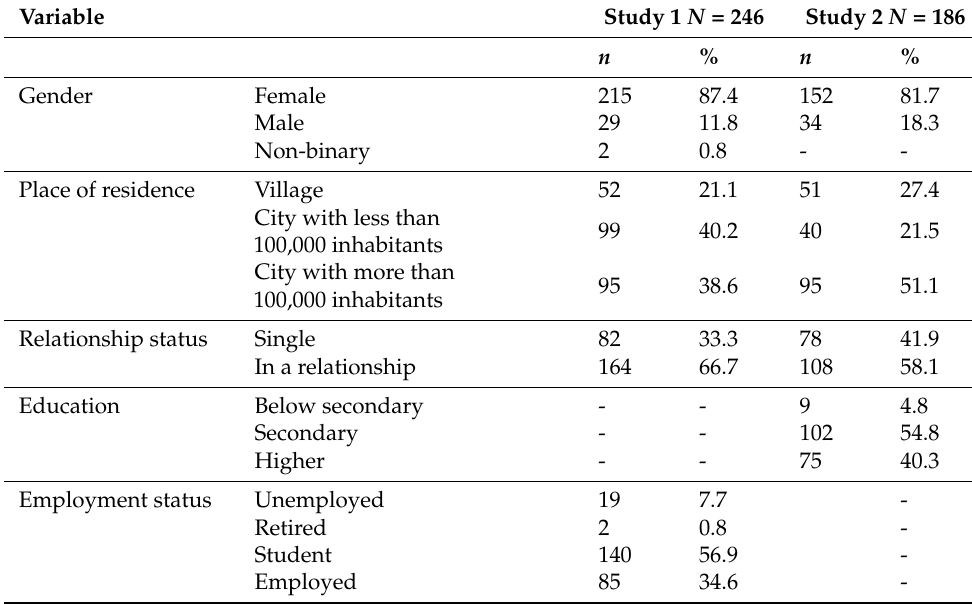
Table 1. Participants’ sociodemographic